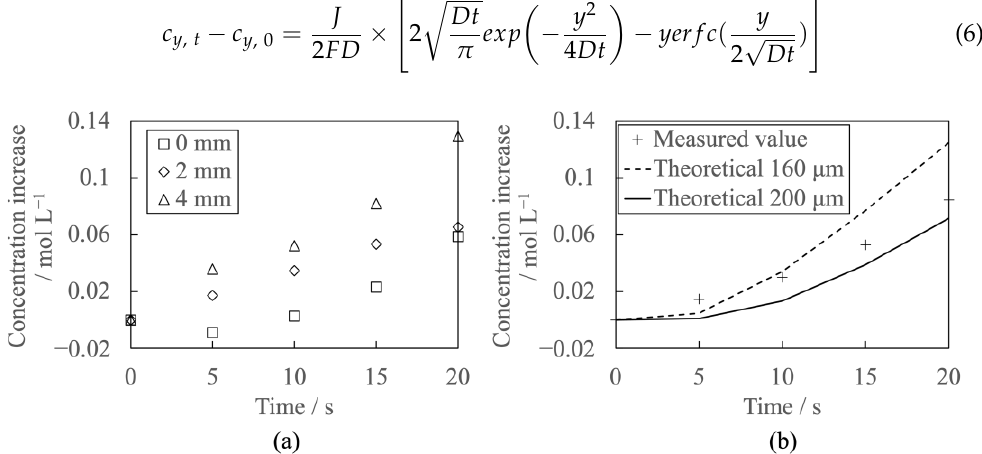
Figure 2. ( a ) Concentration distribution and ( b ) comparison between the theoretical Cu 2+ concen- tration at 160 µ m, 200 µ m, and measured Cu 2+ concentration under DC condition in y -range of 160 µ m–200 µ m.